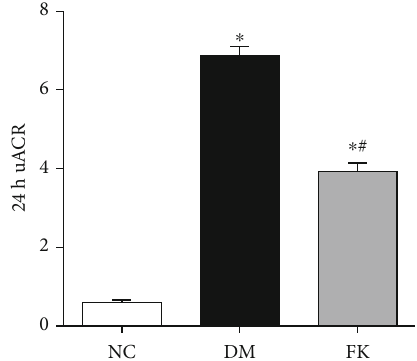
Figure 1: FK506 signi fi cantly ameliorated 24 h uACR of DM rats. ∗ P < 0 : 05 compared to the NC group, ∗ # P < 0 : 05 compared to the DM